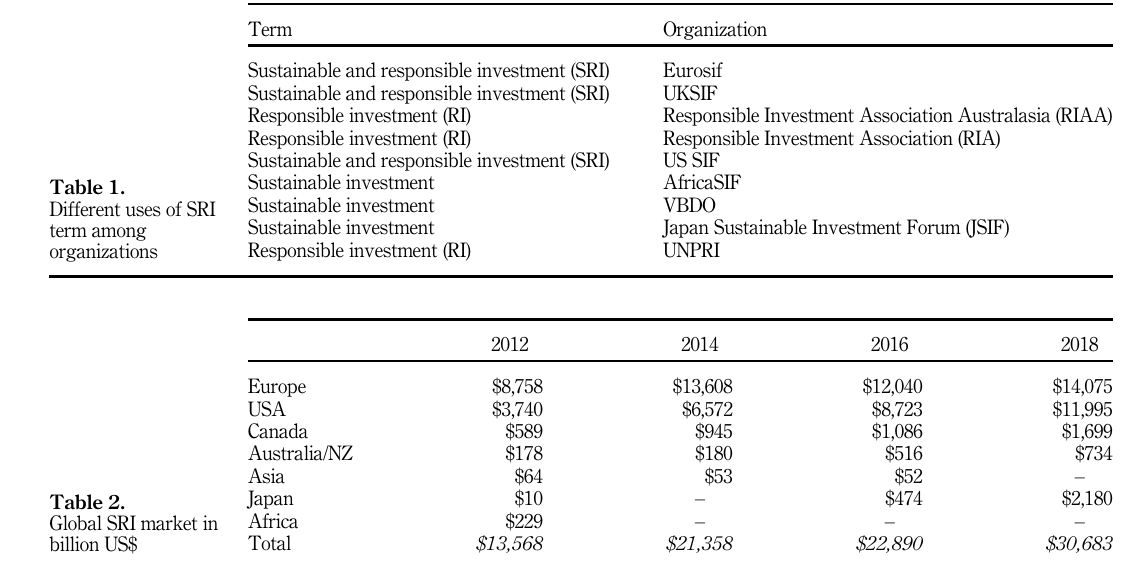
Table 2. Global SRI market in billion